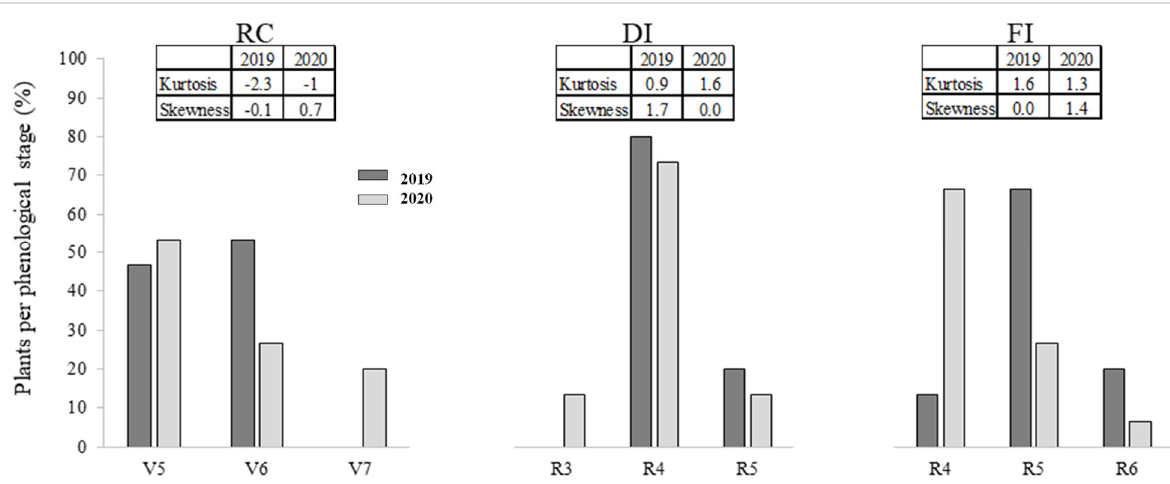
Figure 2. Percentage of plants ascribed to different phenological stage under three water treatments at 100 days from sowing.